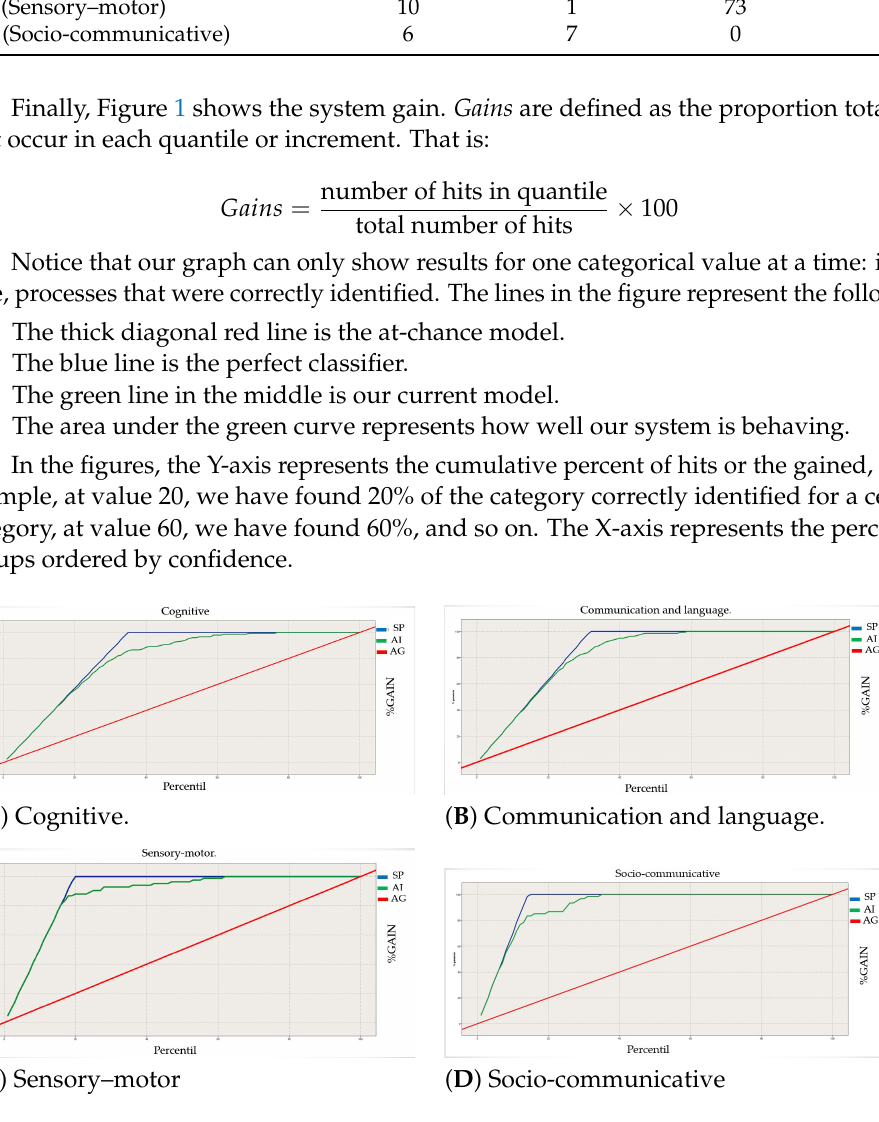
Figure 1. Gain of our artificial intelligent system (AI) against at-chance model (AG). Specialist diagnostic (SP) for the different